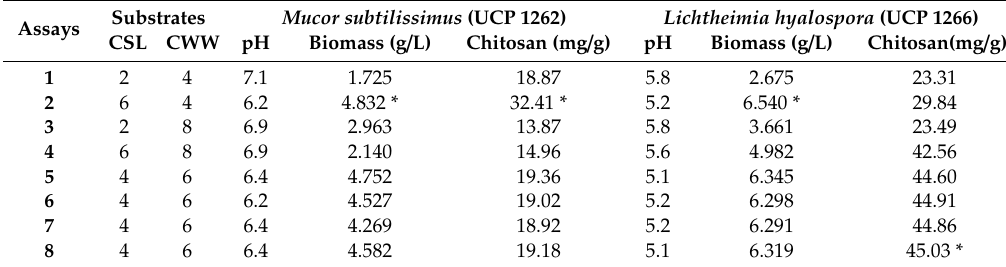
Table 3. Factorial design applied to production of biomass and chitosan by Mucor subtilissimus (UCP 1262) and Lichtheimia hyalospora (UCP 1266) using corn steep liquor (CSL) and wastewater (CWW) as alternatives